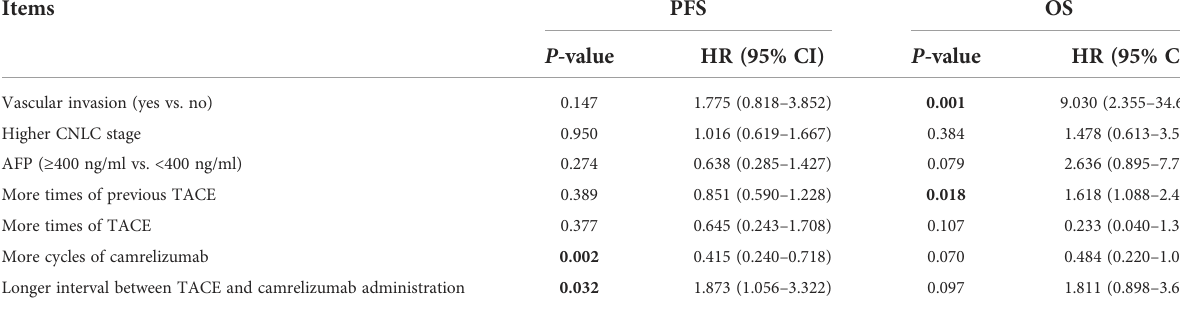
TABLE 4 Factors affecting PFS and OS by multivariate Cox ’ s proportional hazards regression